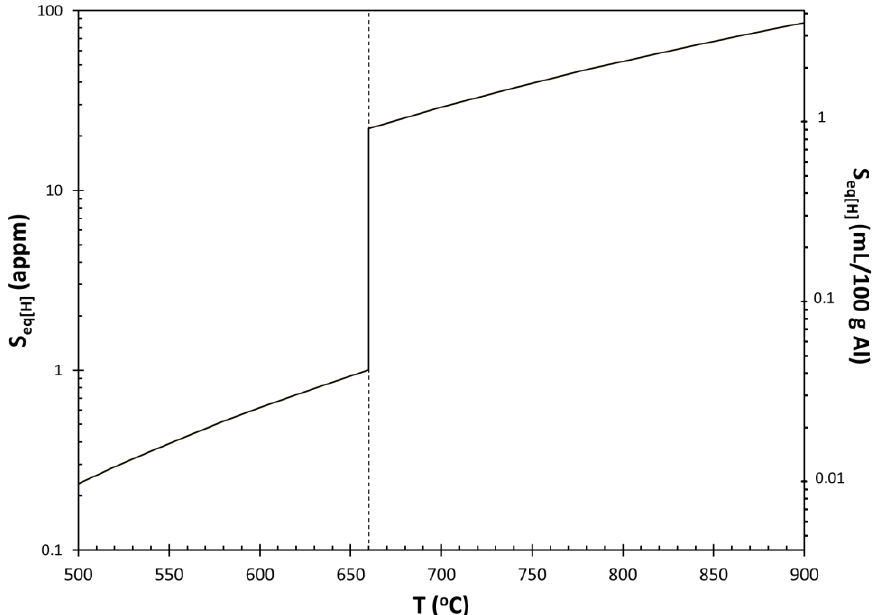
Figure 1. The equilibrium solubility of hydrogen in liquid and solid aluminum as a function of temperature.